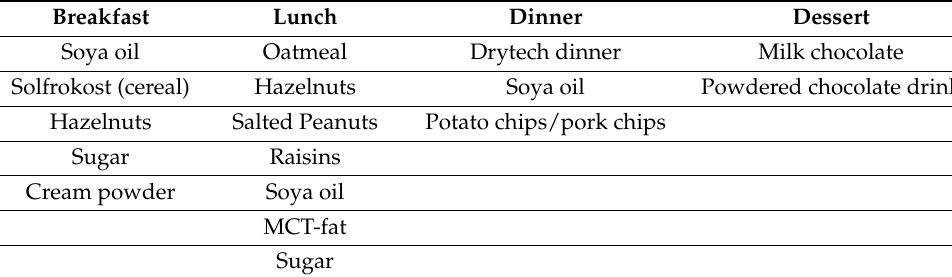
Table 2. Sample of daily meals consumed during the expedition.